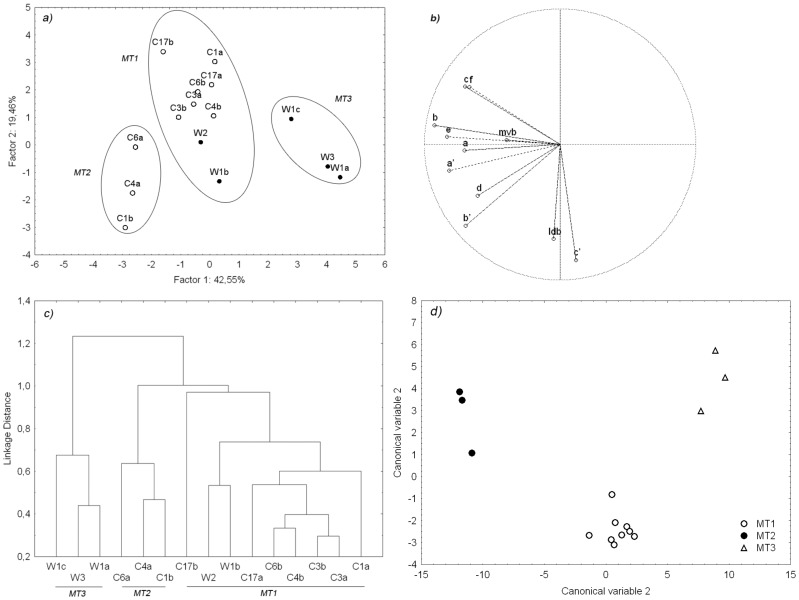
Principal component diagram (Factor 1 and Factor 2) of all morphometric variables measured on Furnestinia echeneis parasites from Sparus aurata from the Adriatic Sea.Solid circles indicate the tree different morphotype groups observed. Each parasite is identified by a letter and number corresponding to the host origin (a); Correlation diagram displaying variables in the two-factor space (PC1 vs. PC2) (b); dendrogram reconstructed using UPGMA on the Euclidian distances computed from standardised morphometric variables between parasite individuals from S. aurata with outlined morphotype groups (c); ordination diagram showing results of the discriminant analysis in the space defined by first two discriminant functions (canonical variables). Three main morphotype groups are clearly separated (d)., cage Adriatic population; •, wild Adriatic population; MT1, morphotype 1; MT2, morphotype 2; MT3, morphotype 3.